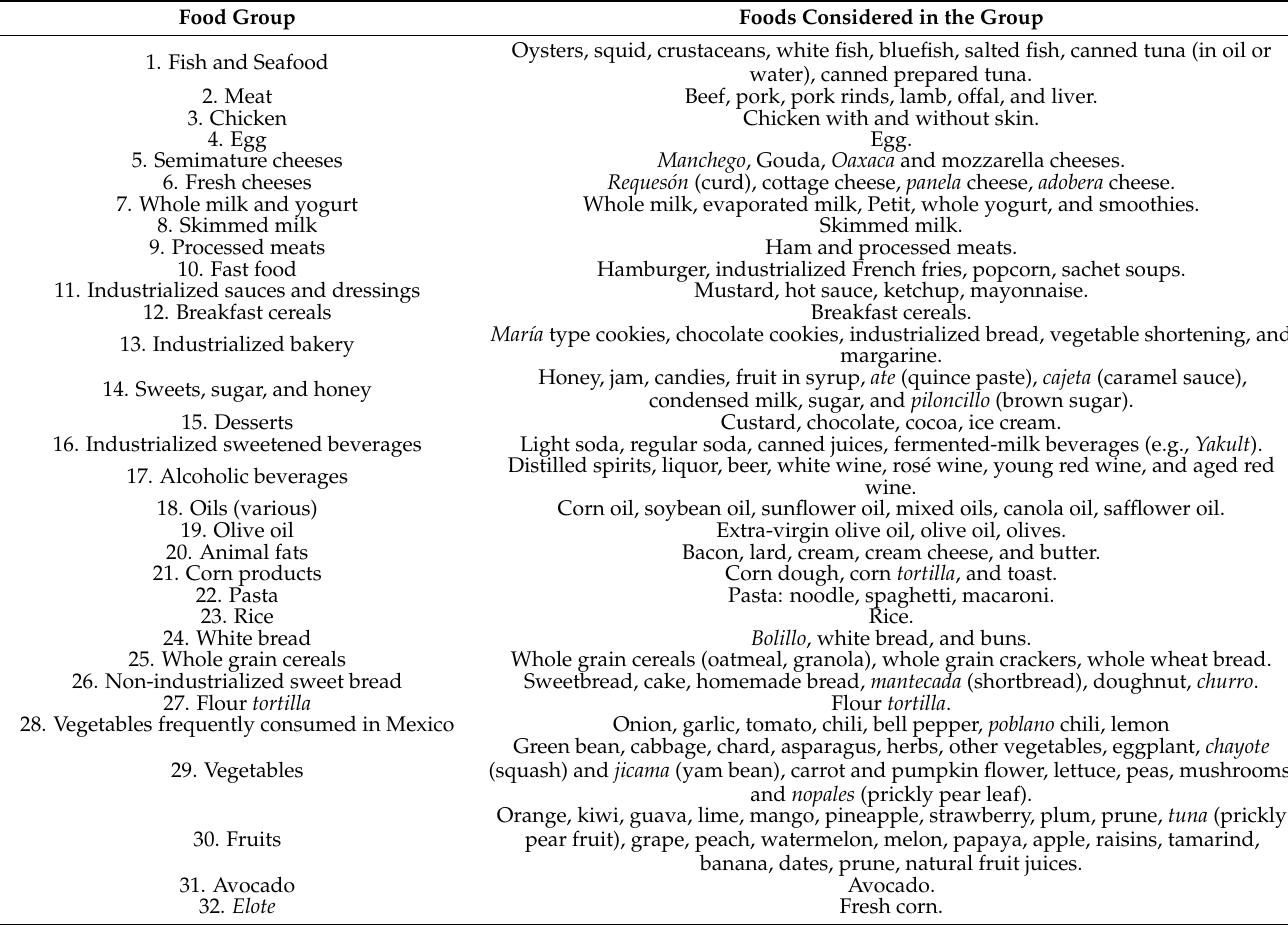
Table 1. Description of the food